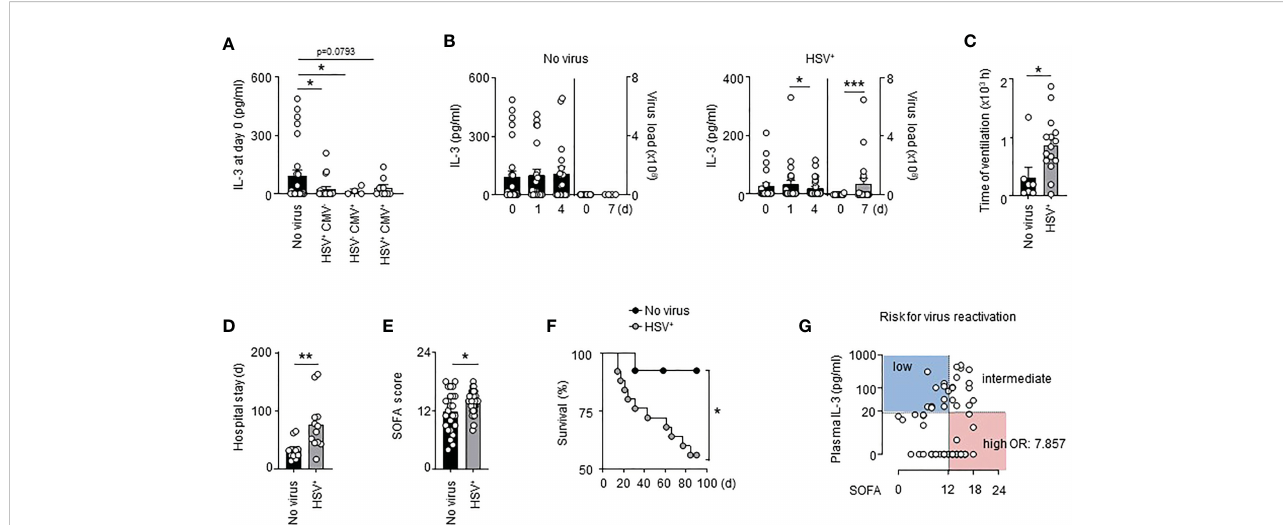
FIGURE 1 Interleukin-3 is associated with reduced viral infections in septic patients. (A) Levels of IL-3 in the serum of septic patients positive for HSV (n=19), CMV (n=4) or both (n=9) in the tracheal secretion or in septic patient without viral pneumonia (n=27). (B) Levels of IL-3 in the serum and viral load in the BALF of septic HSV + patients or septic patients without viral pneumonia at days 0, 1 and 4 after the onset of sepsis (n=55). (C) Time under ventilation of septic HSV + patients or septic patients without viral pneumonia in the VISS trial (n=55). (D) Hospital stay of septic HSV + patients or septic patients without viral pneumonia in the VISS trial (n=55). (E) SOFA score of septic HSV + patients or septic patients without viral pneumonia in the VISS trial (n=55). (F) Survival curve of septic HSV + patients or septic patients without viral pneumonia between the 14 th and 90 th day following sepsis onset (n=38). Data were analysed by Log-rank (Mantel-Cox) test. (G) Analysis of plasma IL-3 levels and SOFA score de fi ning risk groups to develop secondary viral infections (low and intermediate vs high; OR: 7.857; 95% CI: 2.607 – 23.682) in the pooled VISS and SEPICER sepsis cohorts (n=72). Data are mean ± s.e.m., *P < 0.05, **P < 0.01, ***P < 0.001, Wilcoxon test or unpaired, 2-tailed Student ’ s t test using Welch ’ s correction for unequal variances was